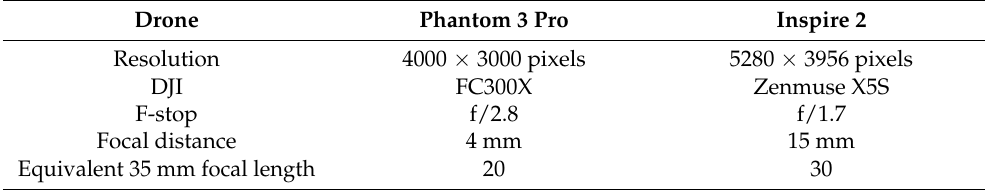
Figure 2. UAVs used in the study: ( a ) Phantom 3 Pro; ( b ) Inspire 2 with a Zenmuse X5S camera. Table 3. Camera and image specifications for the Phantom 3 Pro and Inspire 2 UAV used in the study.